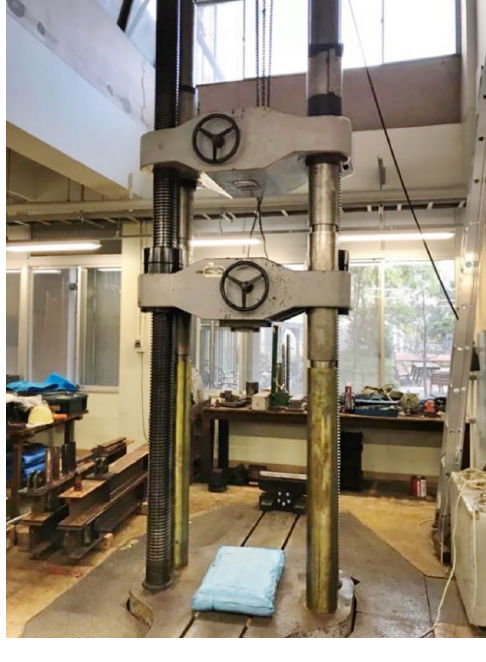
Figure 10. 2MN testing machine